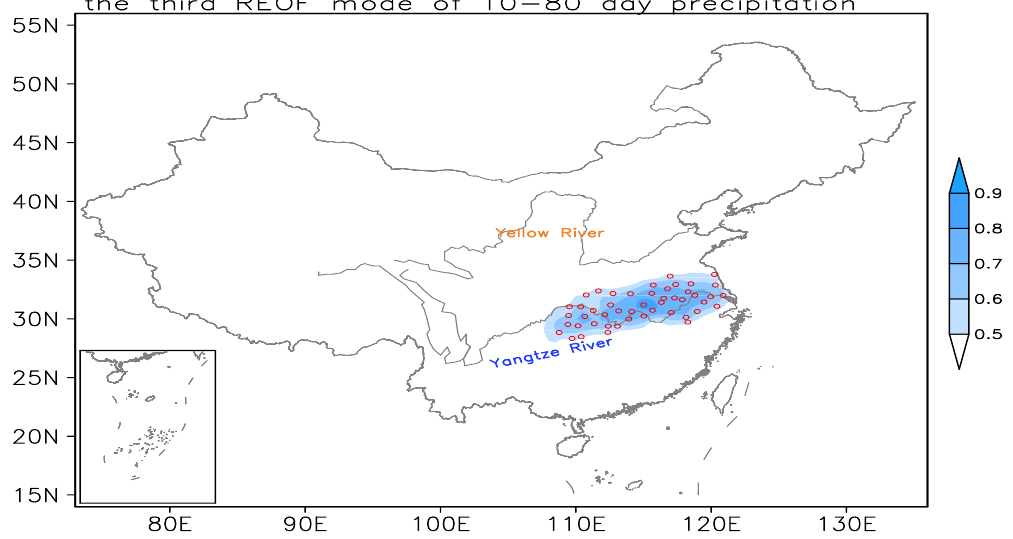
Figure 1. Pattern of the third REOF (rotated empirical orthogonal function) mode for Chinese intraseasonal (10–80-day) precipitation. Stations with maximum loadings (exceeding 0.4 mm day −1 ) are marked as red circles, and shading indicates correlation between Chinese precipitation and the principle component of the third REOF mode with the correlation coefficients above 0.5. Table 1. Names and coordinates (latitude in °N and longitude in °E) of the selected 48 stations over the middle and lower reaches of the Yangtze River basin.